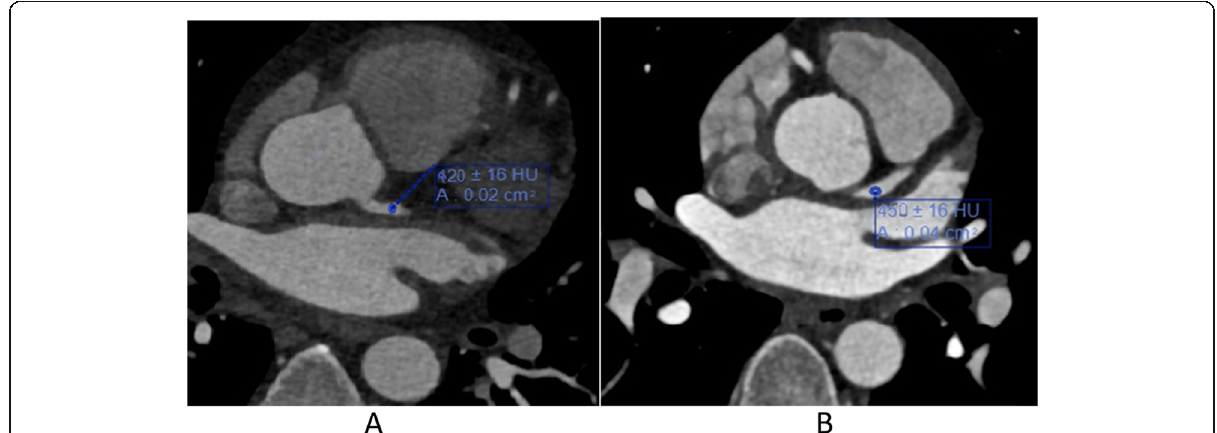
Fig. 3 a CCTA scan of a 44-year-old male, with atypical chest pain using conventional IV catheter 18 G. Axial image showing vessel attenuation at the region of interest (ROI) in the lumen of the left main coronary artery about 420 HU. b Comparative image of the same patient with follows up CCTA scan using the new closed IV Catheter 22 G with the same protocol. Axial image showing vessel attenuation at the ROI in the lumen of the same left main coronary artery was higher about 450